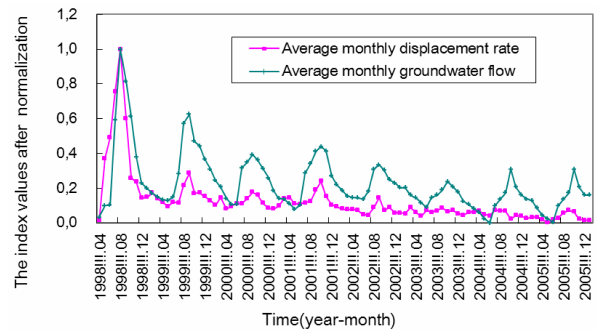
Fig. 5. The relationship between the displacement rate and ground- water flow for the